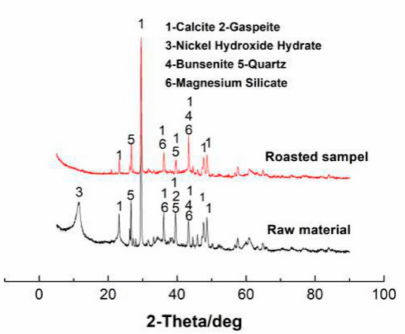
Figure 1. X-ray diffraction pattern of the nickel-containing residue.